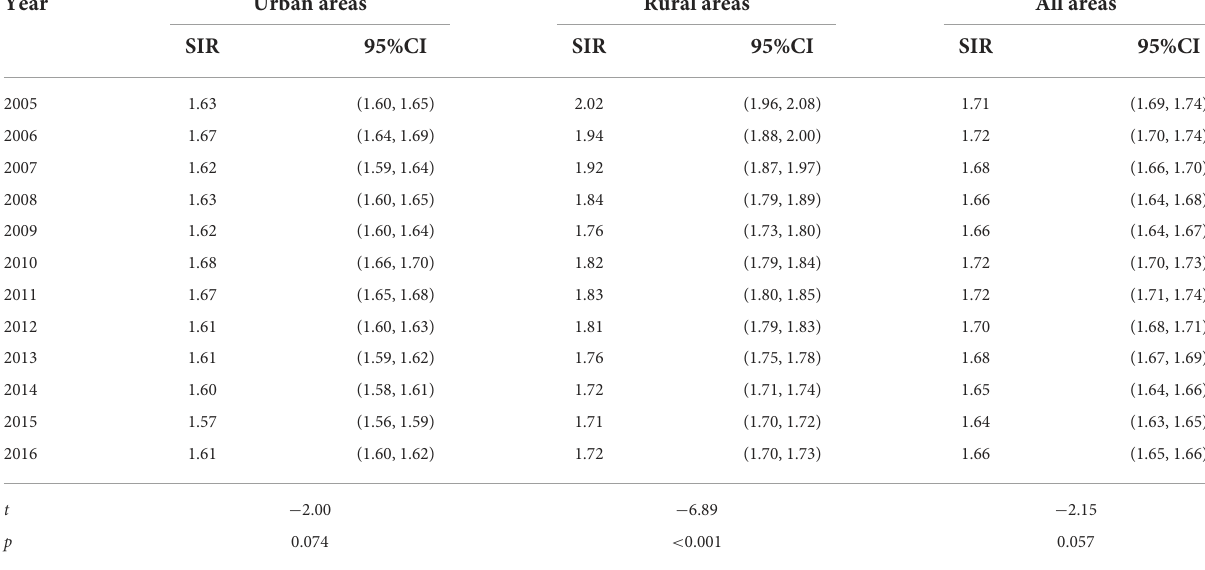
TABLE 3 The sex (male/female) incidence ratio in Chinese older adults aged 60 and above from 2005 to 2016. Year Urban areas Rural areas All